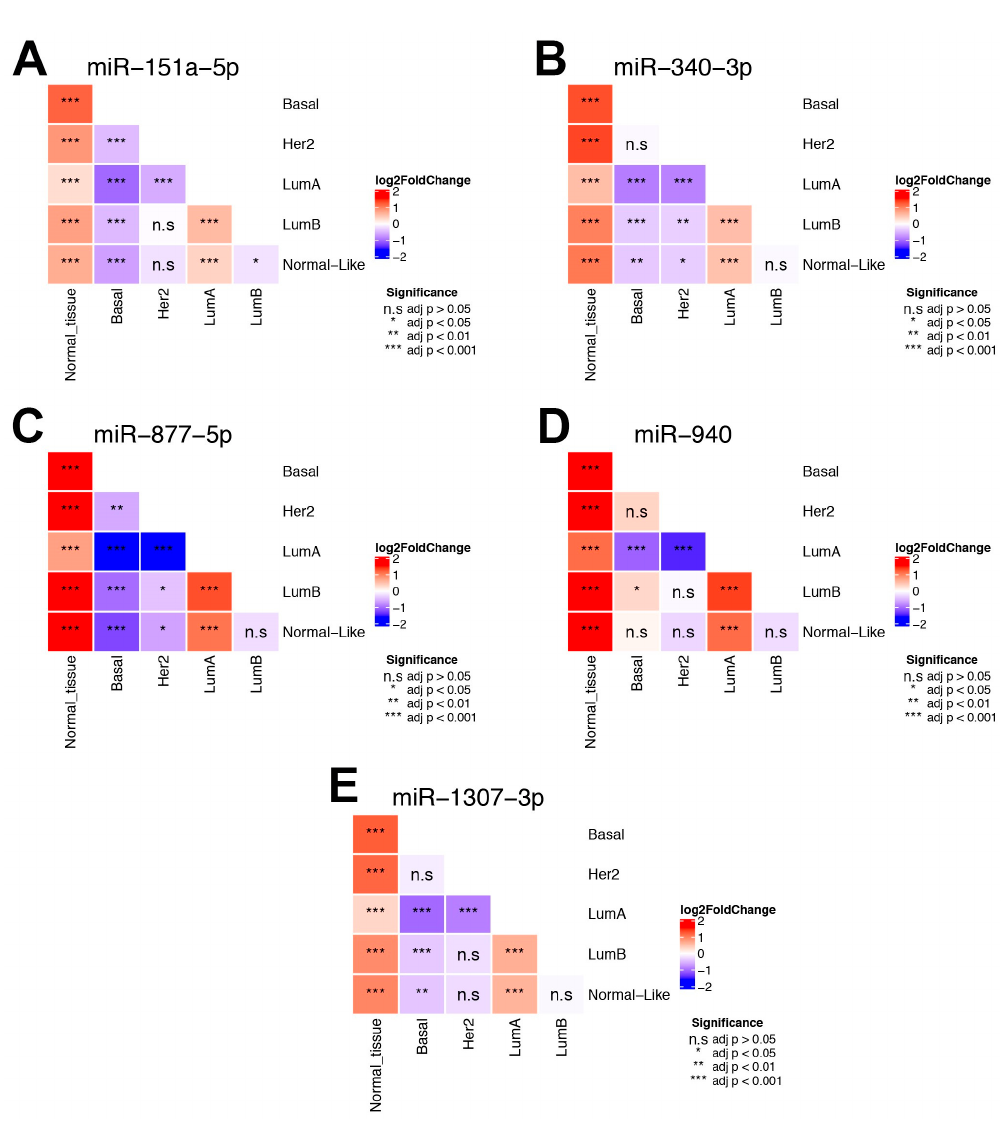
Figure 9. Differential expression of the five MMRs between PAM50 intrinsic subtypes. ( A ) Shows the differential expression of miR-151a-5p. The heatmap represents the log2FoldChange between each subtype comparison, where red shows a positive foldchange and blue a negative one. Significance is shown inside each cell, where * = adj p < 0.05, ** = adj p < 0.01, *** = adj p < 0.001 and n.s = adj p > 0.05. ( B ) Represents miR-340, ( C ) Depicts miR-877 5p, ( D ) Shows miR-940 and ( E ) Represents the differential expression between subtypes of miR-1307-3p.